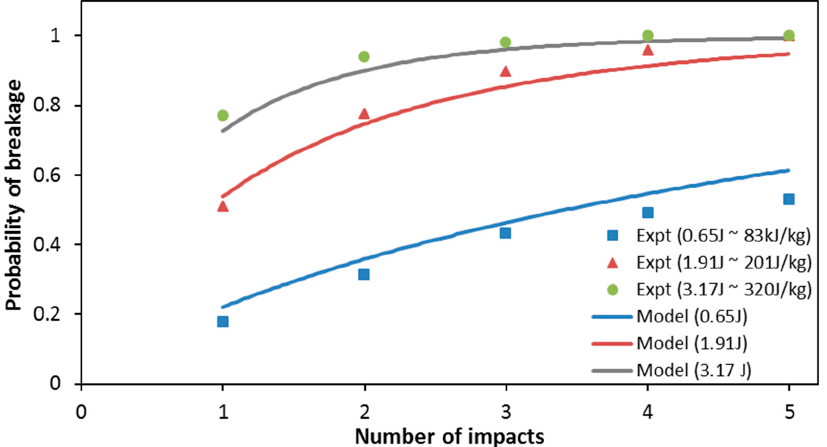
Figure 6. Comparison of experiment breakage probabilities with the model prediction for the − 19 + 16.0 mm silica particles.